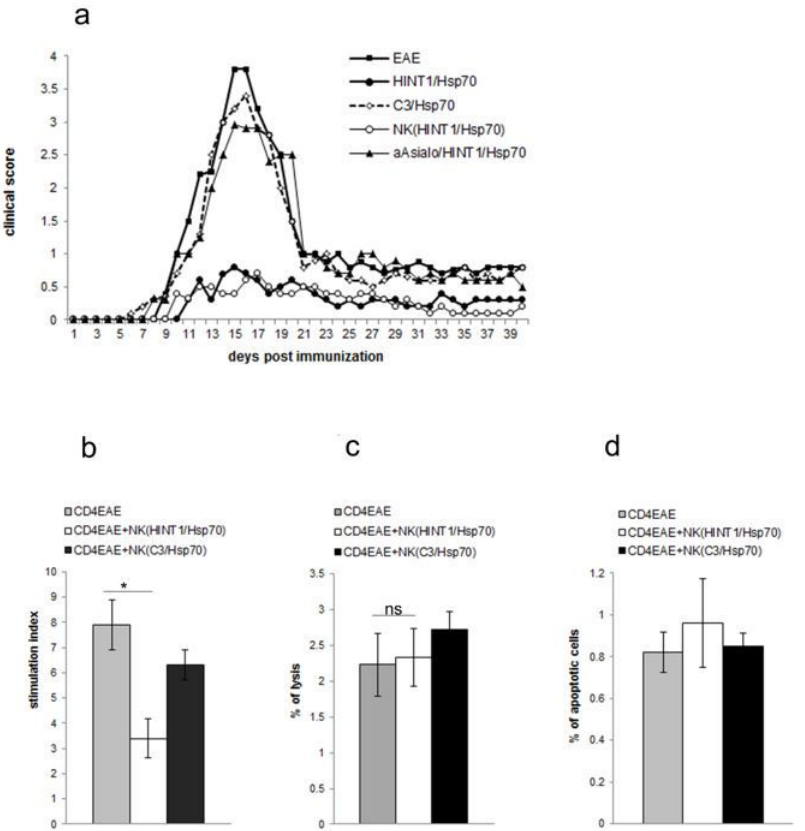
Figure 1. ( a ) The course of experimental autoimmune encephalomyelitis (EAE) was assessed in five groups of SJL / J mice: 1. non-pretreated (black squares); 2. pretreated with HINT1 / Hsp70